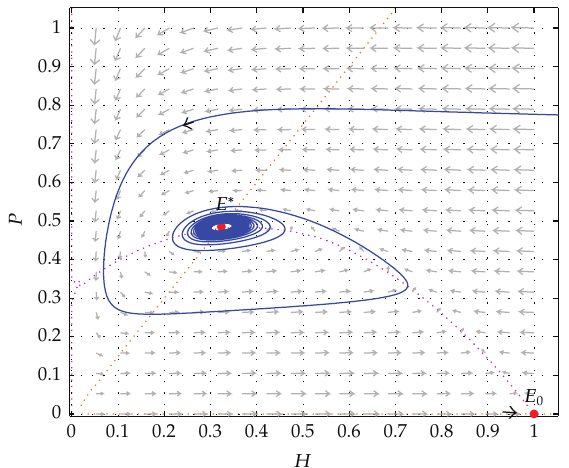
Figure 5: The phase portrait of model (7) with the weak Allee effect. The parameters are taken as 𝑎 = 0.25 , 𝛿 = 0.8 , 𝑚 = 1.3 , and 𝑟 = 0.025265 . The model enters into a Hopf bifurcation around 𝐸 ∗ = (0.3232928050, 0.4849392075) at 𝑟 = 𝑟 ∗ .